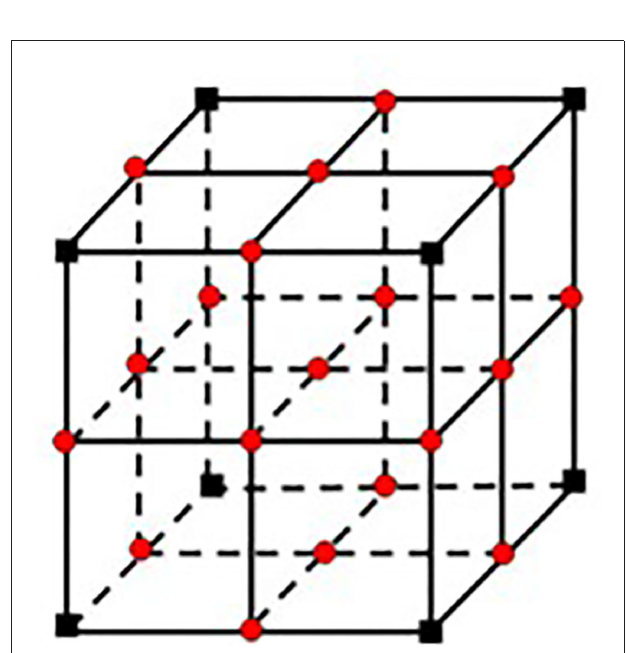
FIGURE 6 | The figure illustrates the proposed system architecture for finding linear and nonlinear access paths for brain